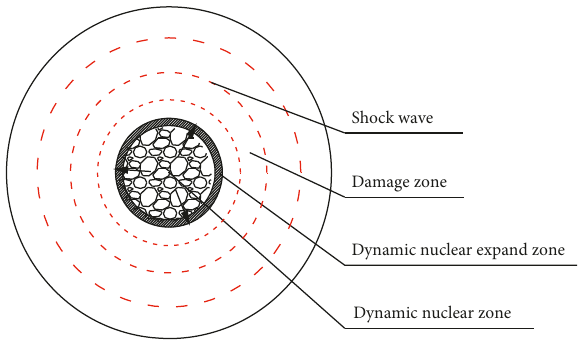
Figure 4: Dynamic nuclear zone failure